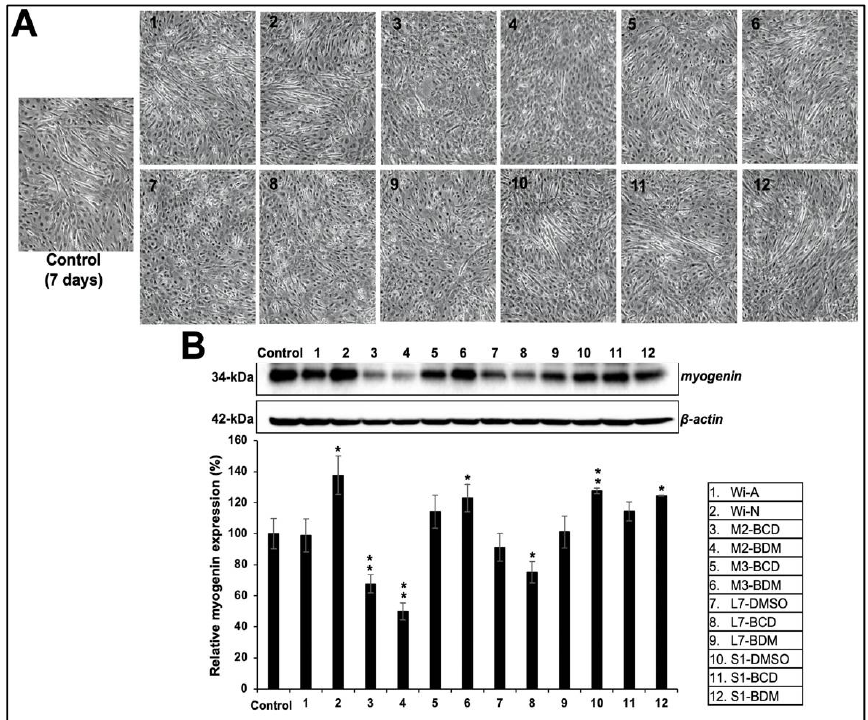
Figure 4. Effect of Ashwagandha extracts and purified withanolides on differentiation in C2C12 cells. ( A ) Phase contrast microscopic images showing the cell morphology and appearance of myotubes in control and treated cells. ( B ) Western blotting analysis for myogenin protein (master regulator and biomarker for muscle cell differentiation) after incubation of Ashwagandha withanolides. Quantitation of the results is shown below (mean ± SD, n = 3), * p < 0.05, ** p < 0.01 (Student’s t -test to